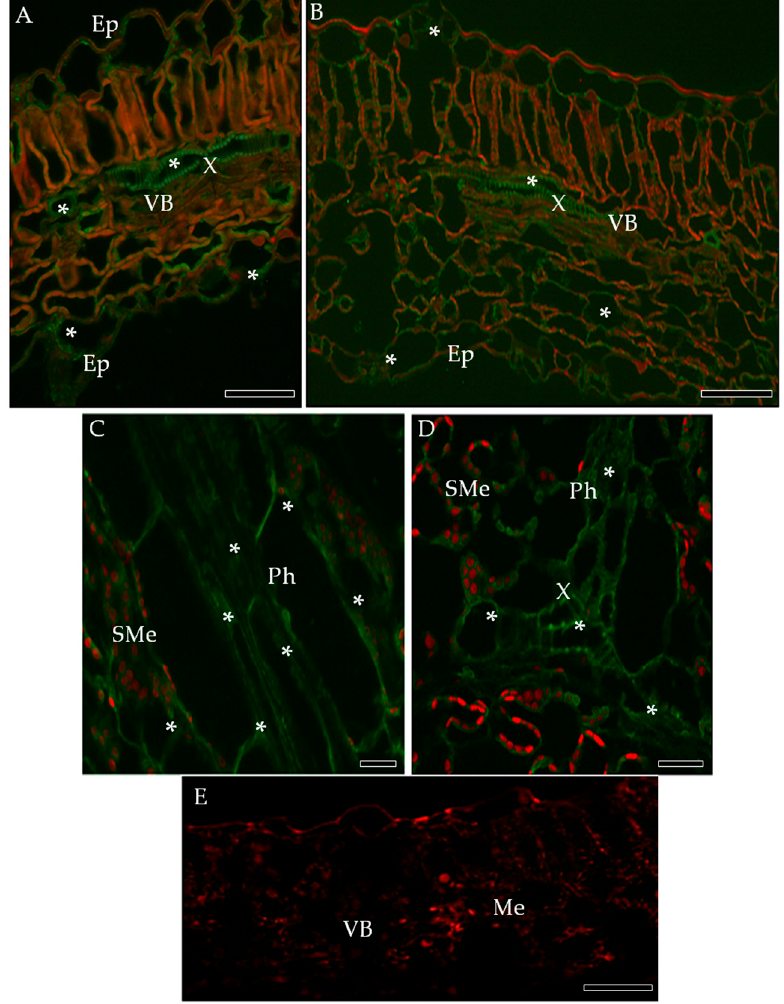
Figure 6. Fluorescence detection of CesA4 protein in potato–PVY NTN compatible ( B )